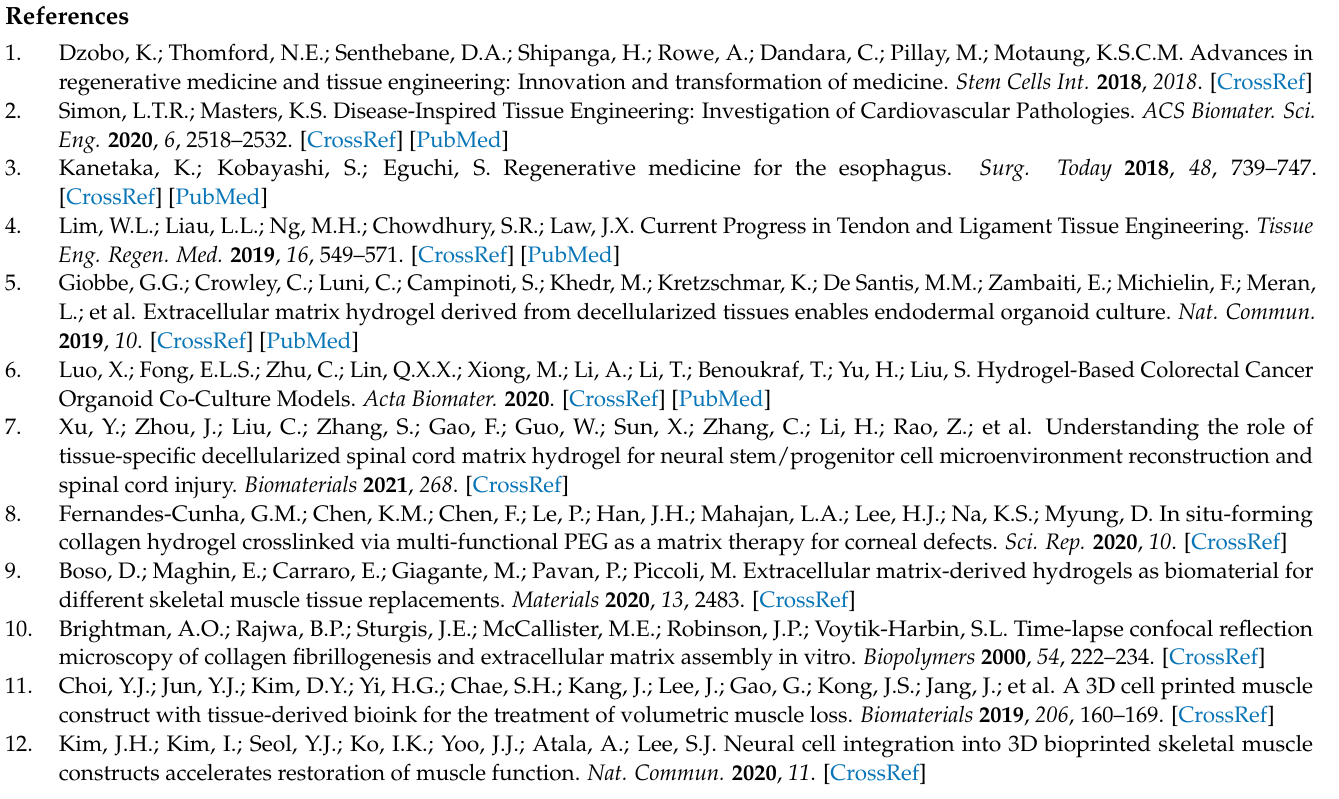
Figure S2: 2% w/v dECM-derived hydrogel characterization, Figure S3: Preparation and analysis of cross-linked 3% w/v dECM-derived hydrogel application in ex vivo CDH model, Figure S4: In vitro hydrogel biocompatibility. Table S1: List of proteins found in dECM with mass spectrometry, Table S2: List of primary and secondary antibodies used. Movie S1: Cross-linked 3% w/v hydrogel mechanical stimulation in ex vivo CDH